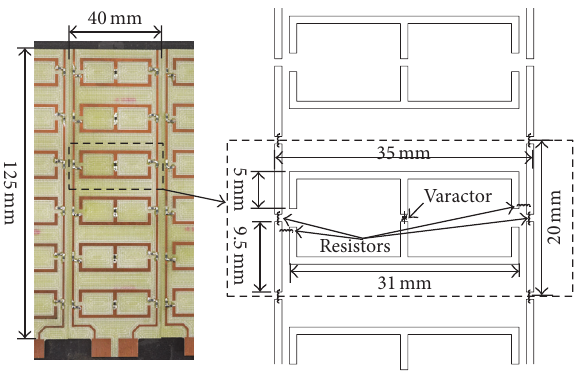
Figure 3: AFSS structure and